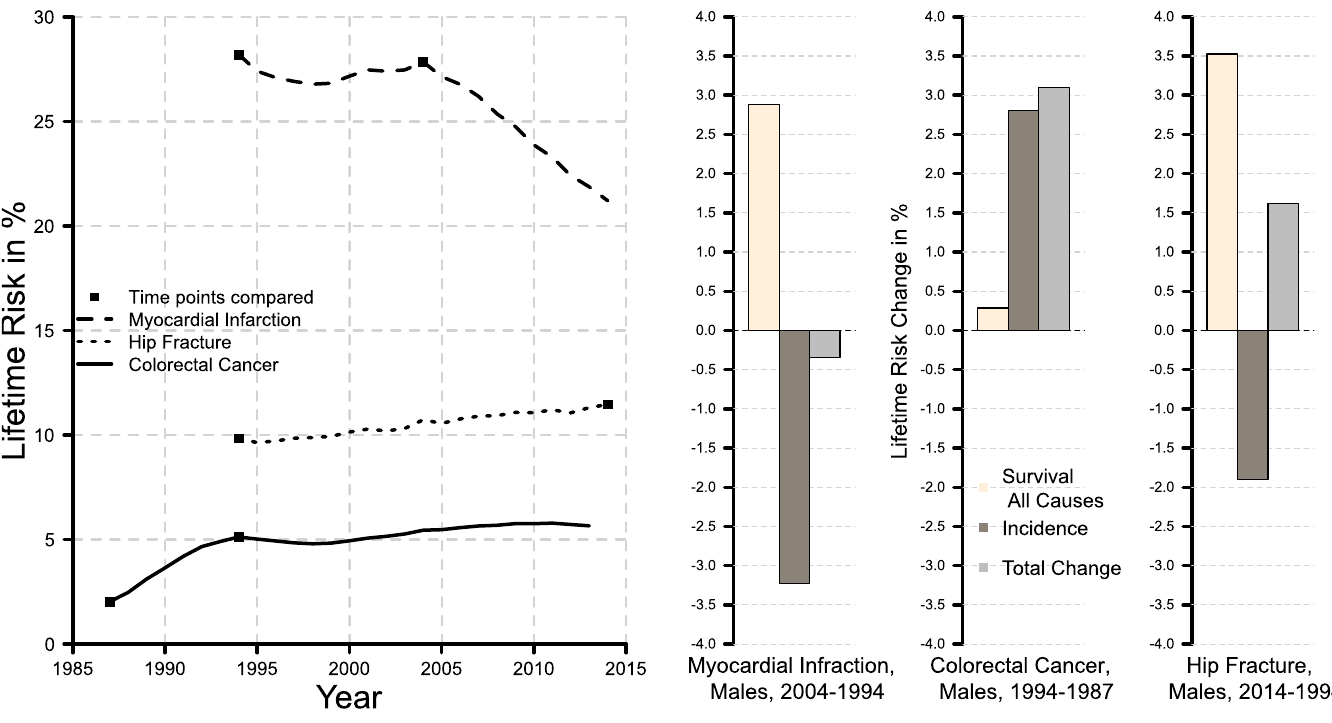
Fig 1. Remaining lifetime risk at age 60 and lifetime risk decomposition for myocardial infarction, hip fracture and colorectal cancer, Sweden,